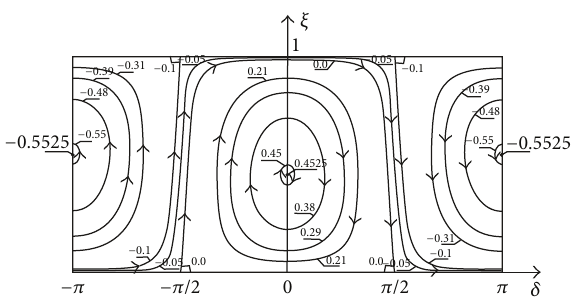
Figure 4: Phase portrait for the case of 1:1 internal resonance 𝜔 1 = (1/2)𝐾𝑏 −1 = 0.1 𝜔 2 at